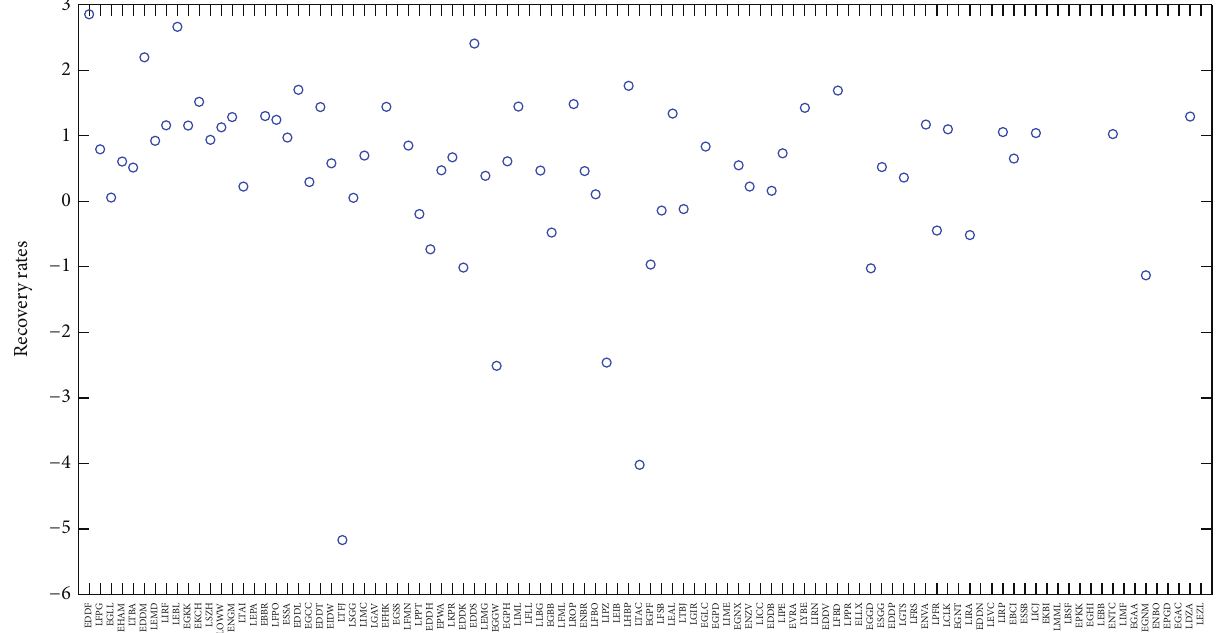
Figure 7: Recovery rates for airport-based metapopulation model (from 13:30 to 16:30 on June 02, 2015).